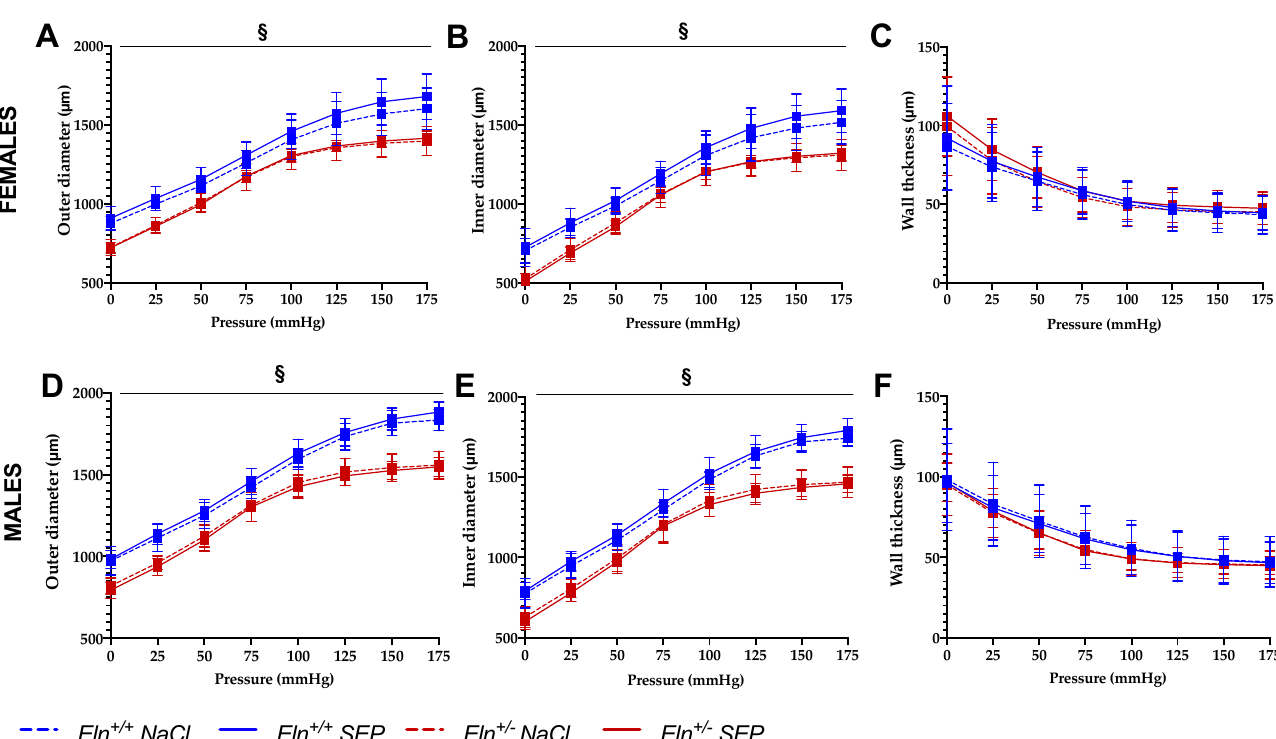
Figure 2. Diameter–pressure and wall-thickness–pressure curves of the cannulated ascending aorta. The measurements were performed by pressure arteriography 3 days after NaCl (control) or SEP intravenous injection in the caudal vein of male and female mice of Eln +/+ or Eln +/- genotypes (( A – C ): females; ( D – F ): males). ( A , D ): outer-diameter–pressure relation. ( B , E ): inner-diameter–pressure relation. ( C , F ): wall-thickness–pressure relation. § general significant interaction between genotype and treatment (three-way ANOVA, p ≤ 0.05), showing that SEP treatment induced a diameter elevation in Eln +/+ , not Eln +/- , mice, independently of sex (post hoc Fisher’s least significant difference (LSD) tests, p ≤ 0.05). Control animals were injected with the same volume of 0.9% NaCl. Values are mean ± SEM. n = 7–10 per group.